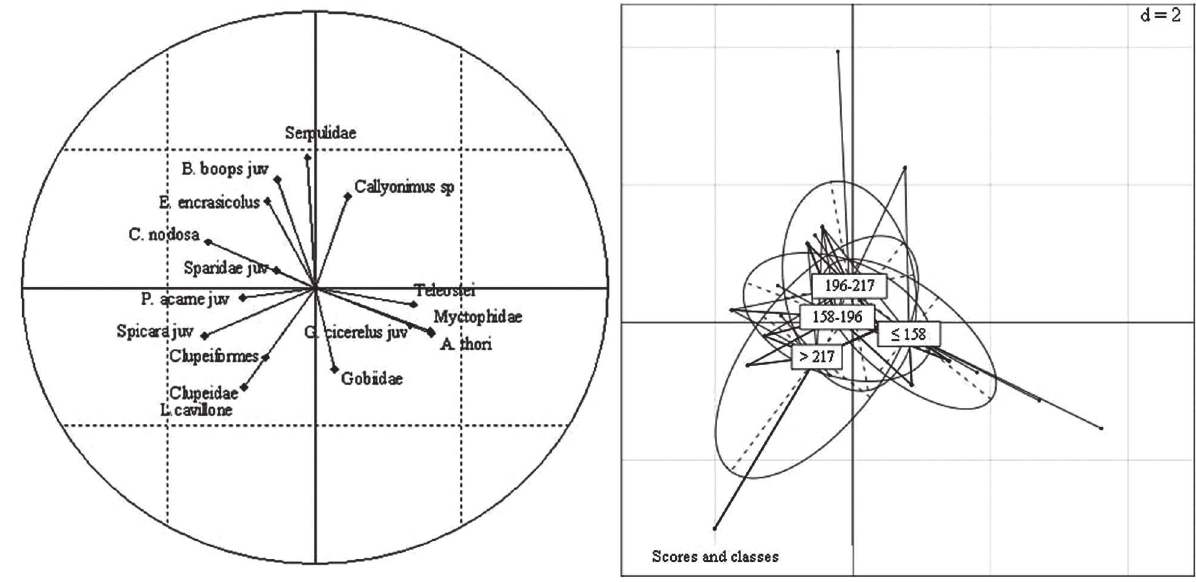
Fig . 6 – correspondence discriminant analysis (cda) computed for predator size classes explaining 77.4% of the total